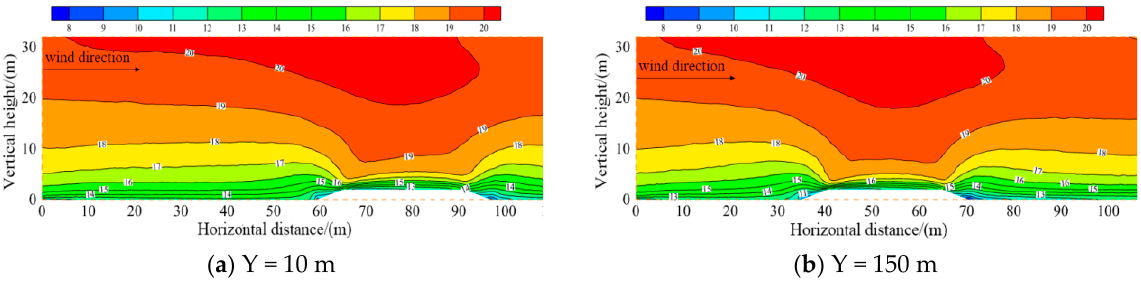
Figure 9. Flow-field distribution of embankment cross-section at different line positions on convex windward curve.